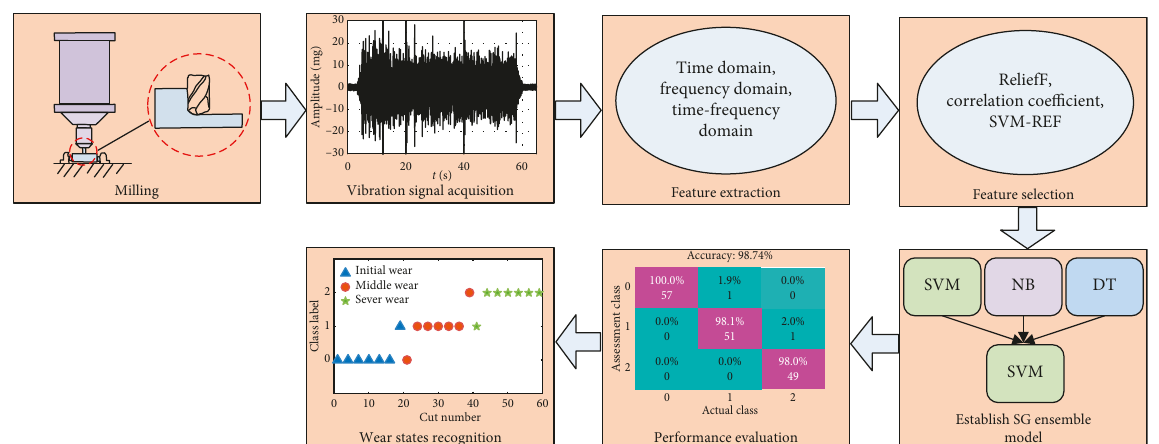
Figure 2: The structure of milling tool wear state recognition method. Table 1: List of the extracted features.